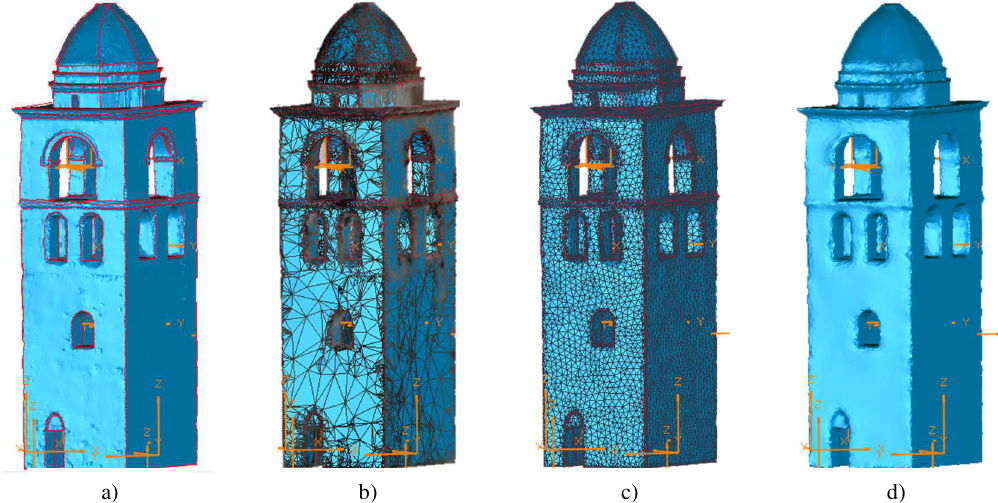
Figure 7 - Mesh evolution inside Geomagic©